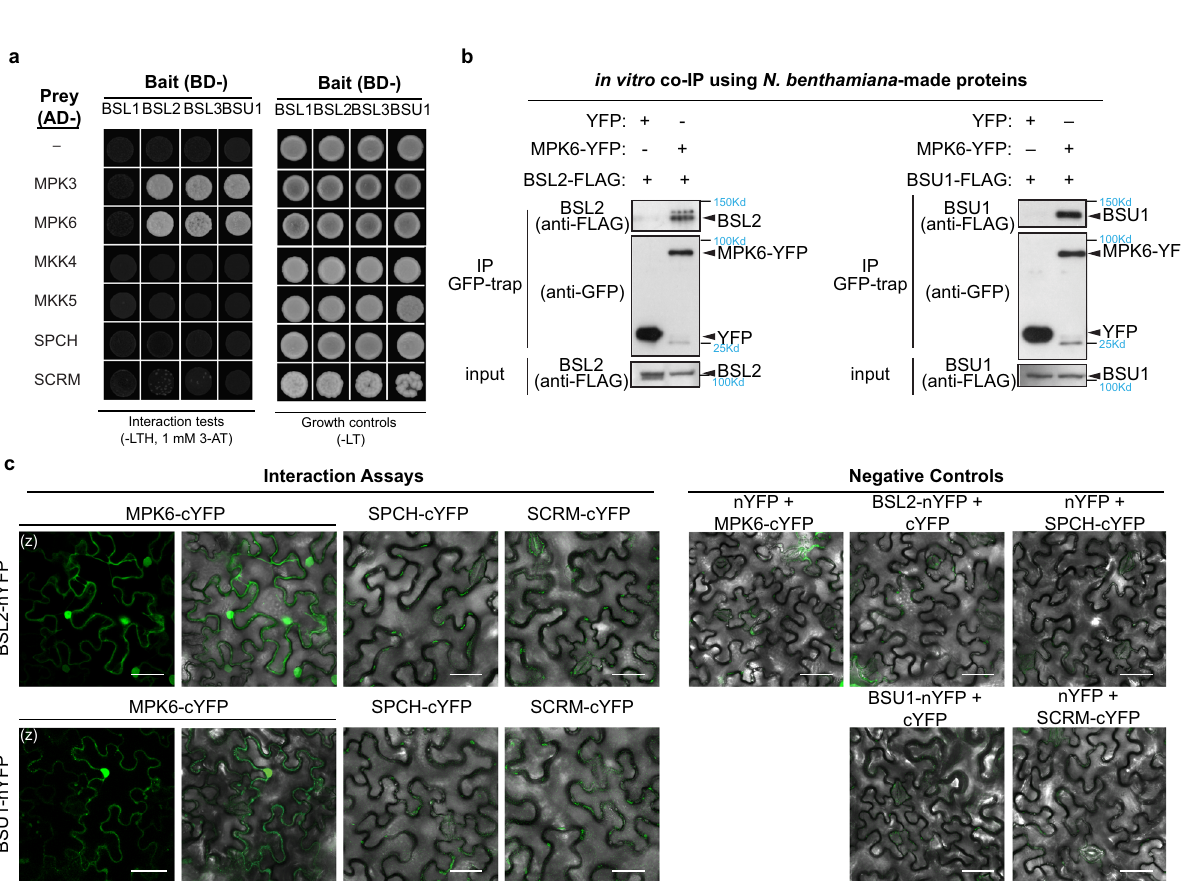
Fig. 4 Nuclear BSL2 functions upstream of MPK6 in stomatal development. a Graphic diagram describes known (solid lines) and unknown (dashed lines) functional regulations surrounding the linear YDA MAPK signaling module in Arabidopsis stomatal development. Arrows and T-bars indicate positive and negative effects, respectively. Phosphorylation modi fi cations are indicated by + p or − p. b – j Stomatal phenotypes in 5-dpg adaxial cotyledon epidermis. b – e Overexpression of membrane-localized BSL2 (myr-BSL2) was introduced in the wild type ( b ), yda ( c ), mpk3;mpk6 ( d ), or loss-of-function bin2-3;bil1;bil2 ( e ) mutants (bottom panels) to compare with their respective genetic background (top panels). f – j Overexpression of nuclear BSL2 (BSL2-nls) was introduced in the constitutively active variant of YDA ( YDAp ::CAyda, f ), constitutively active variant of MKK5 ( TMMp ::CAmkk5, g ), constitutively active variant of MPK6 ( TMMp ::CAmpk6, h ), bin2-3;bil1;bil2 triple mutant ( i ), or spch loss-of-function mutant ( j ) (bottom panels), to compare with their respective genetic backgrounds (top panels). Cell outlines were stained with PI, images were captured by the confocal microscope and converted to black/white. Insets show protein localization (red) in stomatal lineage cells. Data represent results of three independent experiments. Scale bar, 20 μ m. k Quanti fi cation of stomatal lineage index (SLI) for the designated genotypes. Box plot shows fi rst and third quartiles, median (line) and mean (cross). n , number of individual cotyledons. Letters were assigned by ANOVA and Tukey ’ s multiple comparison test ( P ≤ 0.01). Exact P values are 4.7192 e − 15 for i vs . ii, 0.557 for i vs . iii, 3.201 e − 11 for i vs . iv, 3.90248 e − 7 for i vs . v, 1.39073 e − 10 for i vs . vi, 2.32396 e − 6 for i vs . vii, 6.31636 e − 10 for ii vs . iii, 2.12926 e − 12 for iv vs . v, 5.41428e − 9 for vi vs . vii, by unpaired t -test.